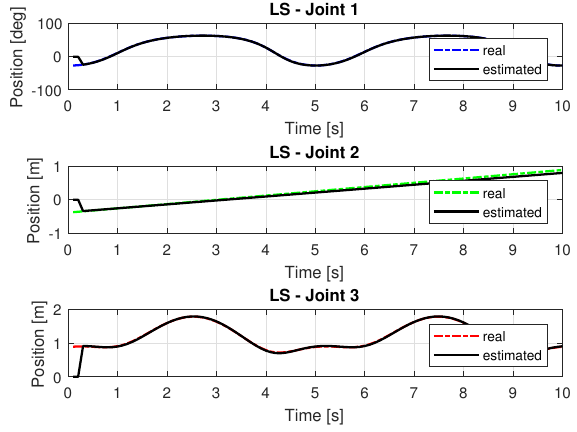
Figure 6. Trajectory in the joint space identified with LS.